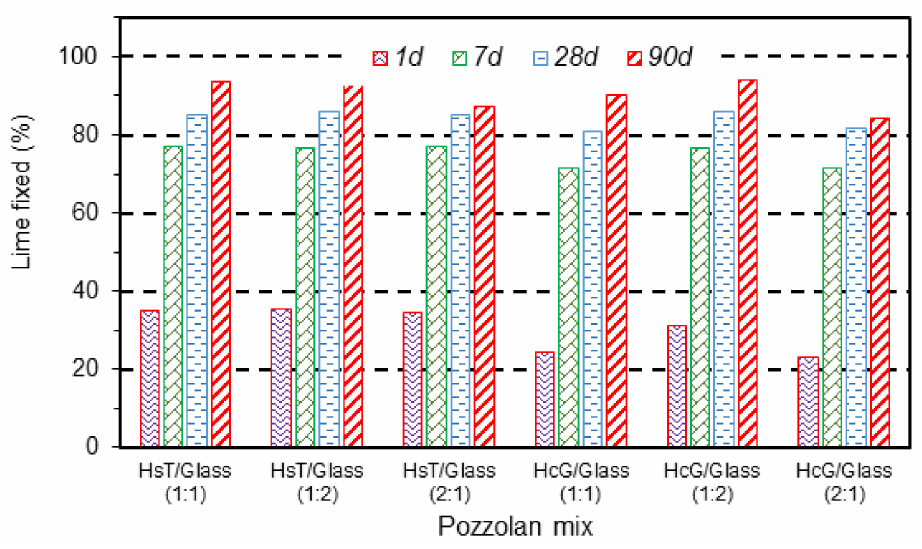
Figure 2. Evolution of fixed lime over the reaction time in the different